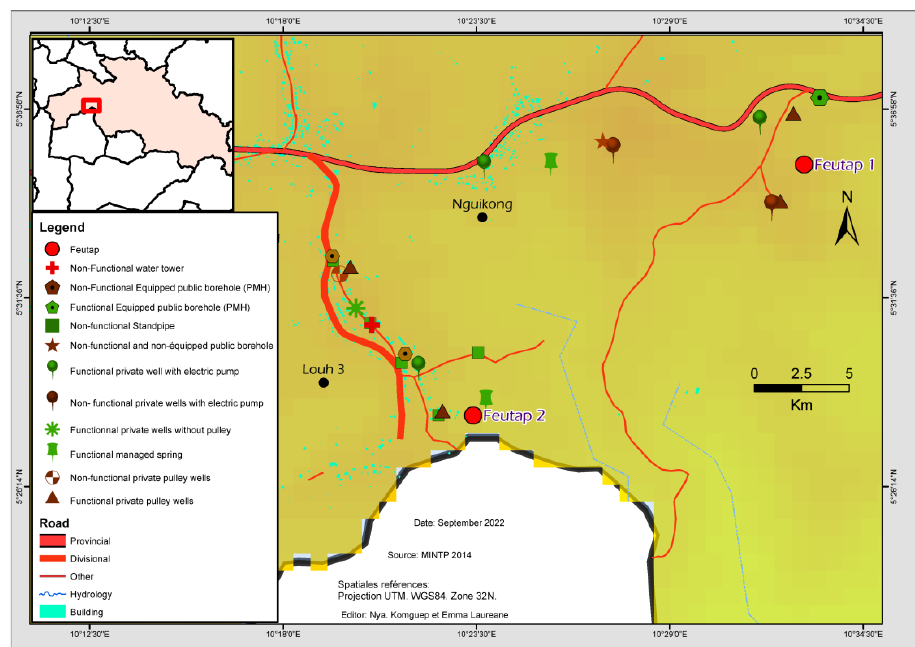
Figure 7. Map depicting the 12 standpipes in Feutap 2.